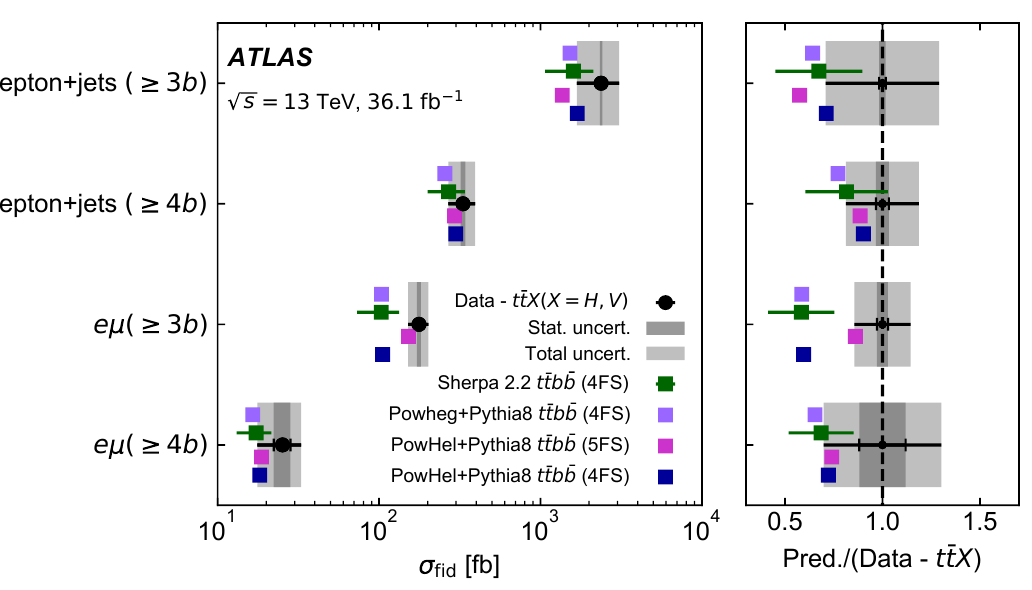
Figure 7. The measured (cid:12)ducial cross-sections, with t (cid:22) tH and t (cid:22) tV contributions subtracted from data, compared with t (cid:22) tb (cid:22) b predictions obtained using Sherpa 2.2 t (cid:22) tb (cid:22) b with uncertainties obtained by varying the renormalisation and factorisation scales by factors of 0.5 and 2.0 and including PDF uncertainties. Comparisons with the central values of the predictions of Powheg + Pythia 8 and PowHel + Pythia 8 t (cid:22) tb (cid:22) b are also made. No uncertainties are included in the subtraction of the t (cid:22) tH or t (cid:22) tV